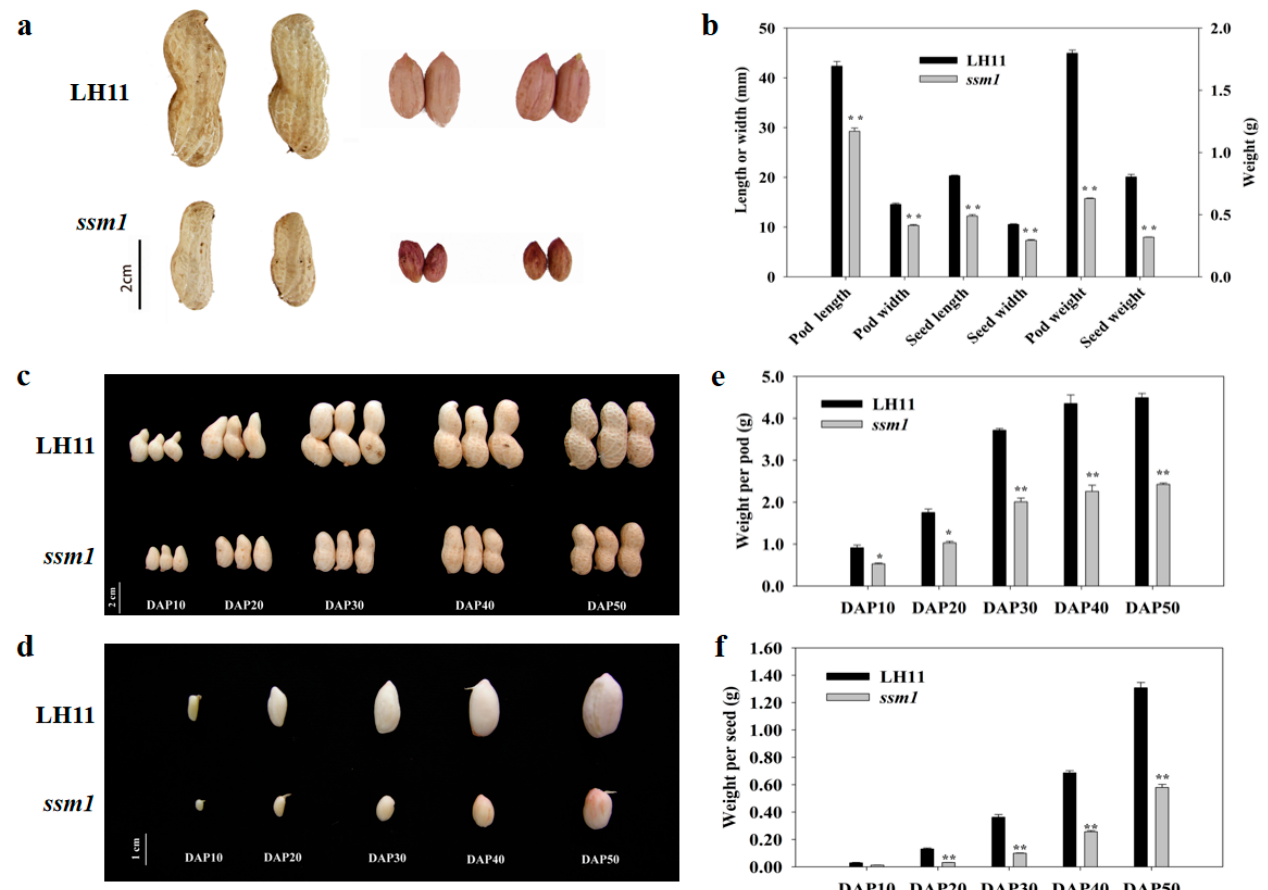
Figure 1. Comparison of pods and seeds between mutant ssm1 and LH11. ( a ) Mature pods and seeds of ssm1 and LH11; ( b ) Mature pod and seed length, width, and weight of ssm1 and LH11; ( c ) The pods of ssm1 and LH11 at different developmental stages; ( d ) Seeds of ssm1 and LH11 at different developmental stages; ( e ) Pod weight of ssm1 and LH11 at different developmental stages; ( f ) Seed weight of ssm1 and LH11 at different developmental stages. DAP10, 10 days after pegging; DAP20, 20 days after pegging; DAP30, 30 days after pegging; DAP40, 40 days after pegging; DAP50, 50 days after pegging. Three biological replicates were used for statistical analysis ( t -test; * p < 0.05, ** p < 0.01). Values in ( b , e , f ) represent means ± SE ( n = 3).